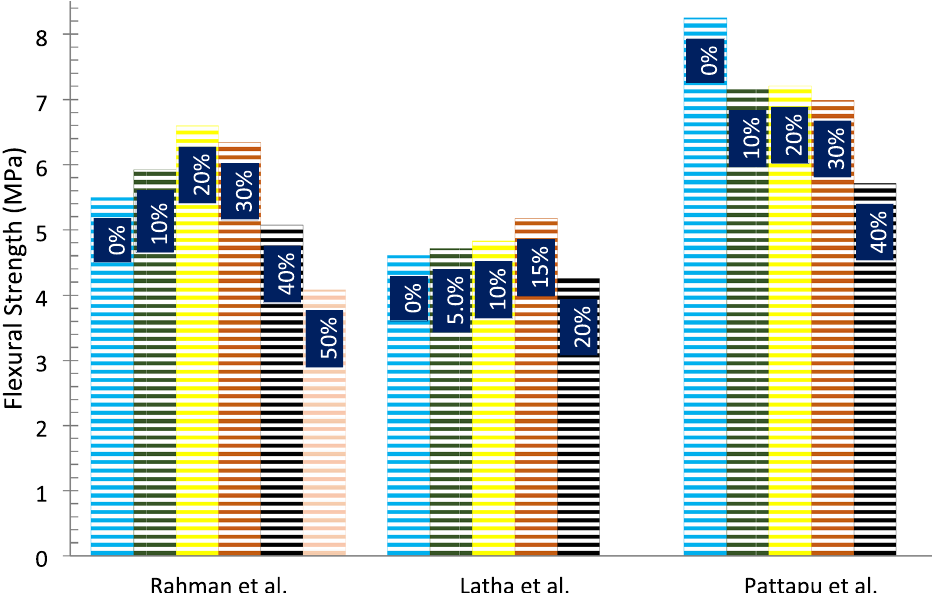
Fig. 12 Flexural strength (Latha et al., 2015; Pattapu & Lal n.d.; Rahman et al.,